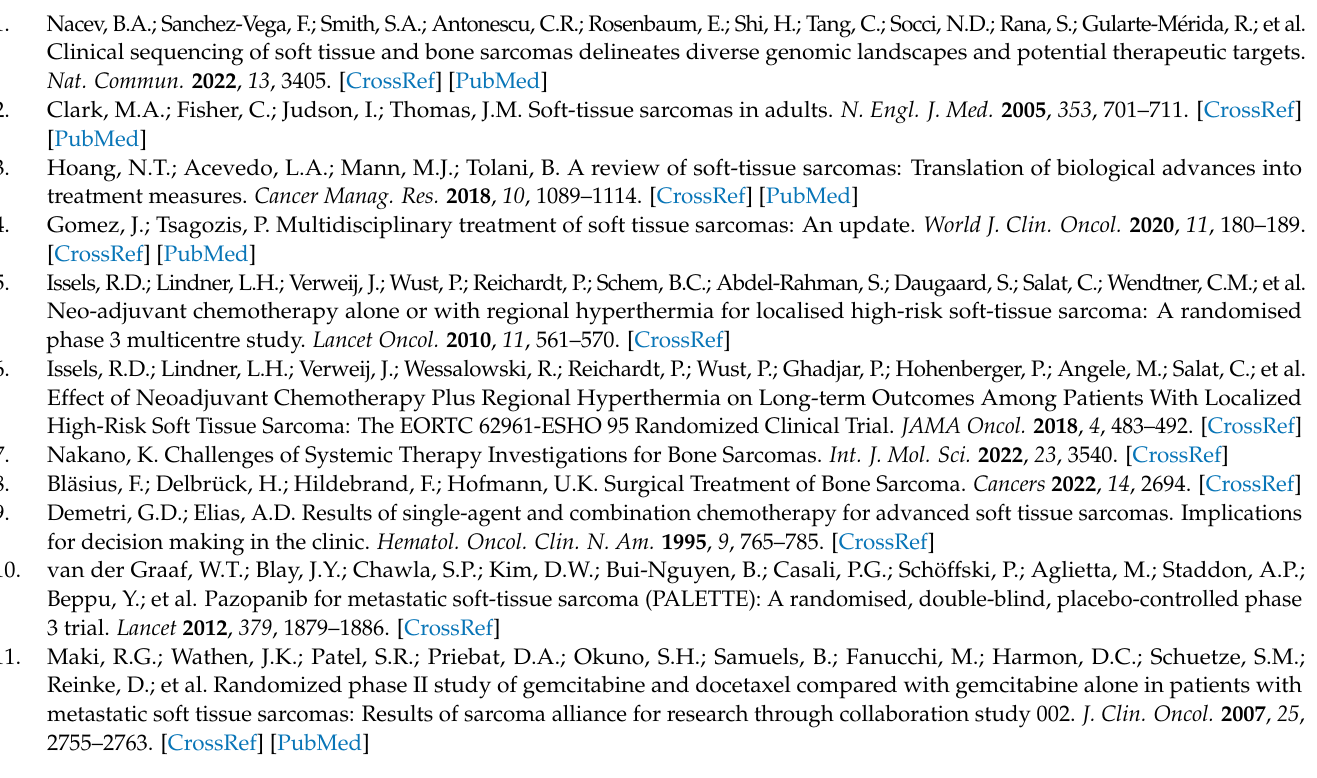
Figure S2: Association of of identified risk factors and PFS; Figure S3: OS in sarcoma patients patients without ifosfamide treatment; Table S1: Occurrence of IIN in sarcoma patients; Table S2: Patient characteristics in sarcoma patients without